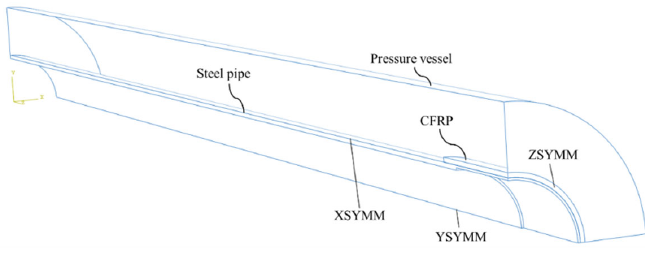
Figure 7. The 1/8 Simplified Model Boundary Condition Diagram.